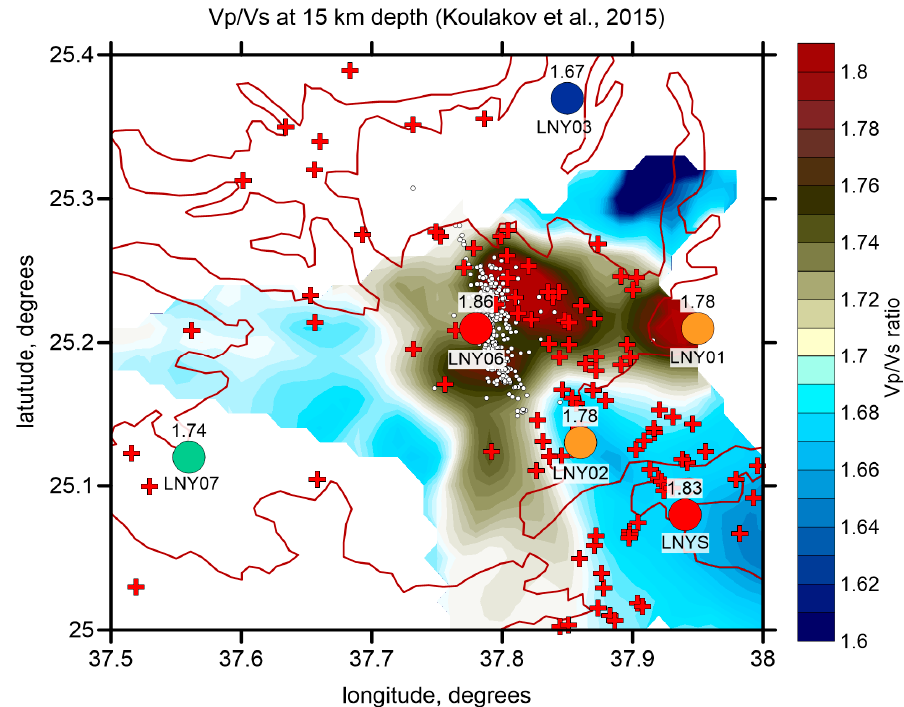
Figure 12. The values of the Vp/Vs ratio for selected stations in Harrat–Lunayyir obtained with the use of the H-k stacking (colored dots, same as in Figure 11) overlapped onto the Vp/Vs ratio at the depth of 15 km derived from local earthquake tomography by [20]. The white dots indicate the locations of events that occurred during the unrest in 2009. The red crosses are the monogenic cones identified from satellite images by [20]. The dark-red contour highlights the harrat limit.